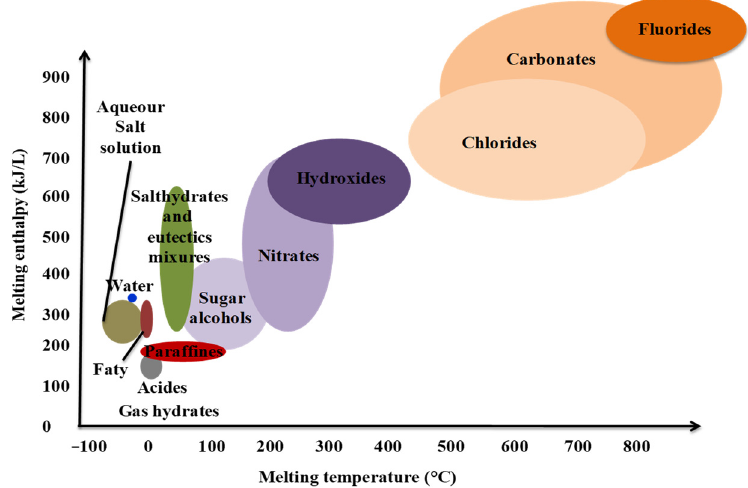
Figure 12. Melting enthalpy vs. melting temperature for some PCMs [77,78,82–84], reprinted/adapted with permission from Ref. [82], 2022, Elsevier.